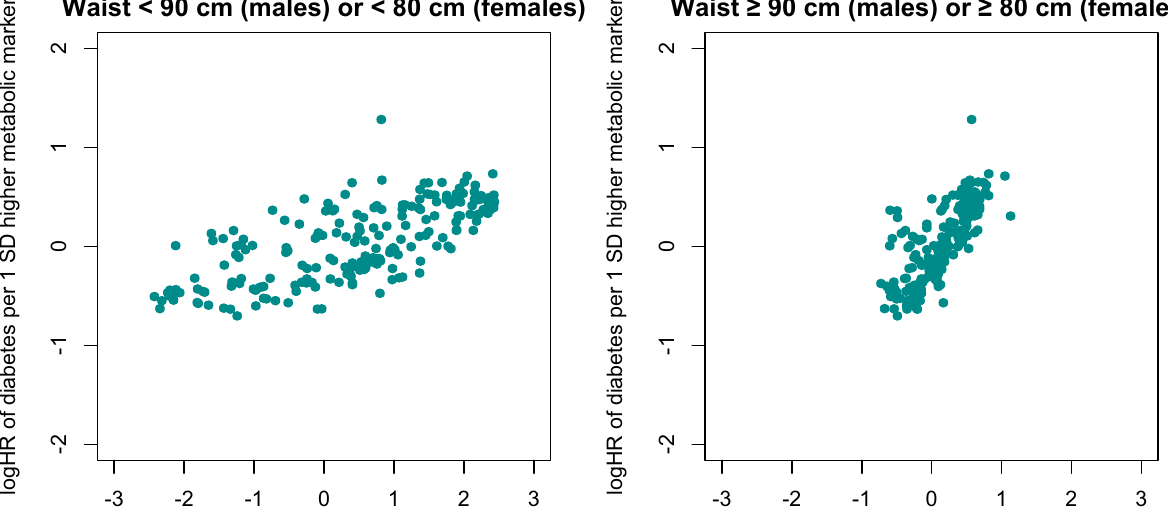
Figure 2. Comparison of differences in adiposity associated with 1-SD higher metabolic biomarkers vs. log- hazard ratios (HRs) for incident type 2 diabetes associated with 1-SD higher metabolic biomarkers, stratified by ( a ) BMI and ( b ) waist circumference. Estimates on the x-axis are the coefficients of linear regression of metabolic biomarkers on ( a ) BMI and ( b ) waist circumference. Estimates on the y-axis are the coefficients of Cox regression of type 2 diabetes on metabolic biomarkers. All estimates are adjusted for age, sex, study area, education, fasting time, smoking, alcohol, physical activity, dietary factors and family history of diabetes. BMI body mass index, WC waist